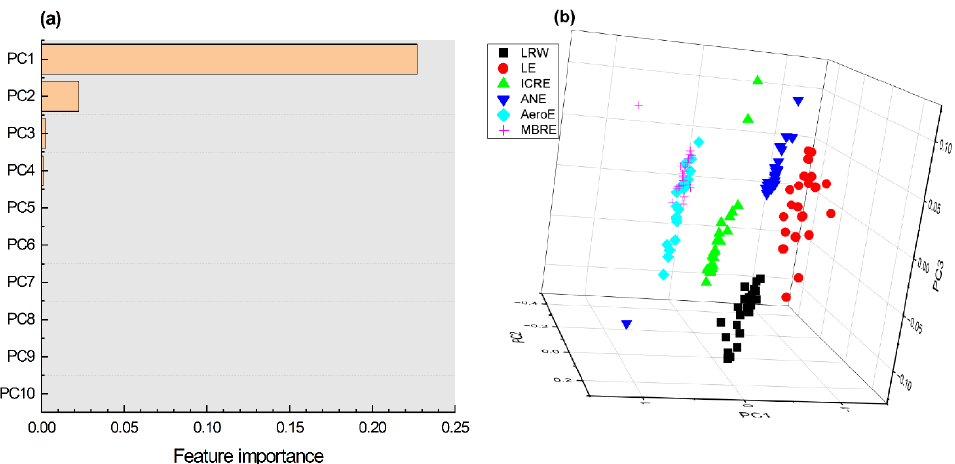
Figure 4. Visualization of e-nose data dimensionality reduction based on PCA: ( a ) feature importance according to variance; ( b ) sample distribution based on the first three PCs.